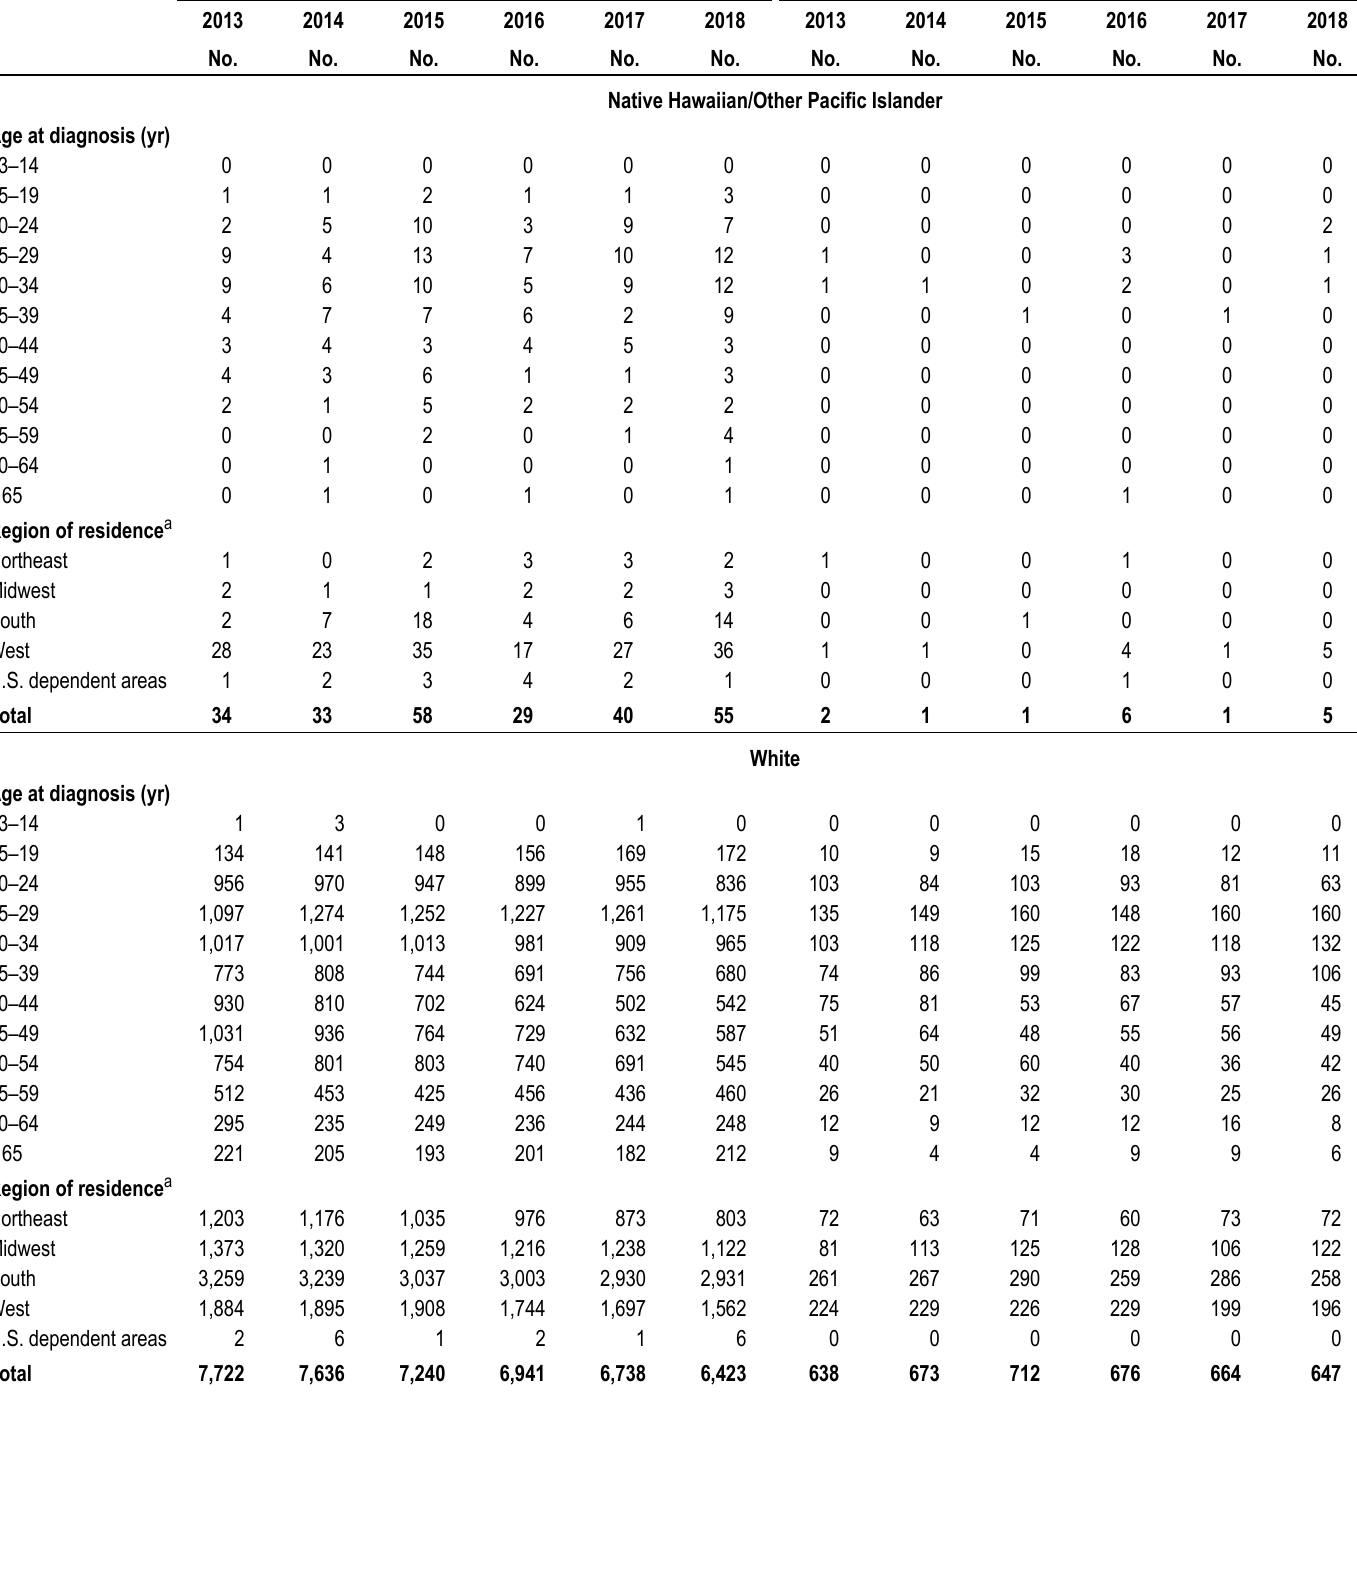
Table 7b. Diagnoses of HIV infection attributed to male-to-male sexual contact and male-to-male sexual contact and injection drug use, by selected characteristics, 2013–2018—United States and 6 dependent areas (cont) Male-to-male sexual contact Male-to-male sexual contact and injection drug